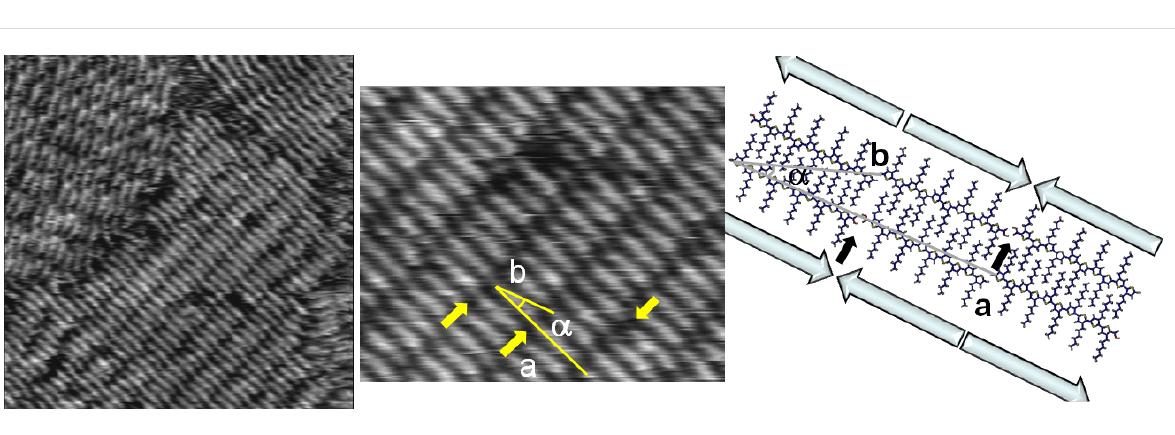
arranged in columns and domains related to the crystallo- graphic axes of the HOPG substrate. The columns are not perfectly straight, in contrast to the stacks of